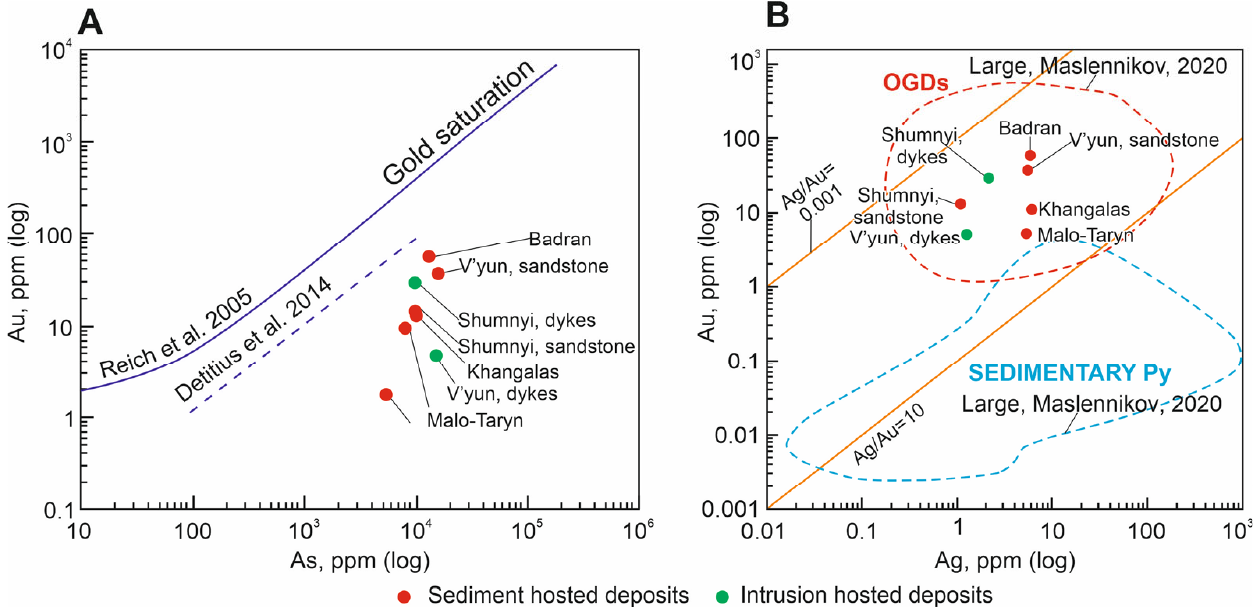
Figure 22. Plot of Py3. ( A ) Au vs. As, the lines of gold saturation after [32,49]; ( B ) Au vs. Ag of the studied OGDs, central YKMB. The demarcated fields are after [119].